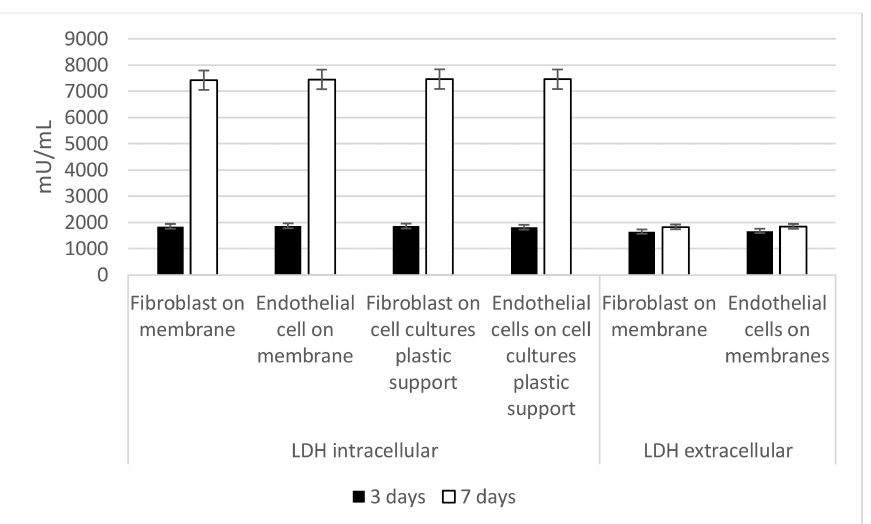
Figure 5. Quantification of intracellular and extracellular Lactate Dehydrogenase (LDH) activity. Intracellular LDH activity proves that cells are able to produce metabolites if seeded onto both surfaces, with improved results after 7 days from seeding. Extracellular LDH activity confirms that metabolites are secreted by the cells and are not associated with damage of the membrane.